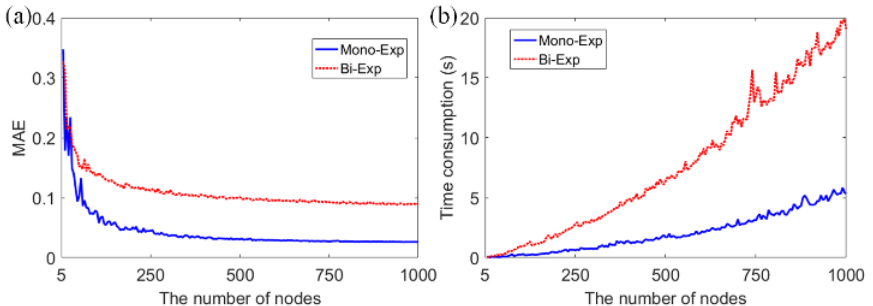
Table 2. Comparisons of Existing NN Architecture for Lifetime Estimation. Figure 7. ( a , b ) Loss curves and time consumption vs. different numbers of nodes in the hidden layer. Algorithm